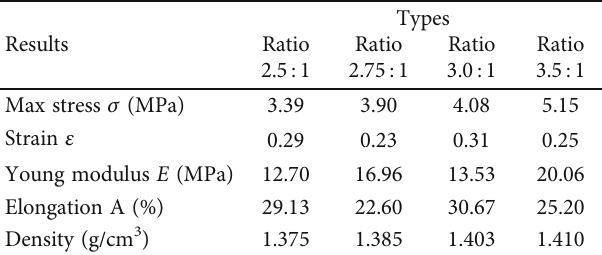
Table 3: Results of mechanical properties of bioplastics.